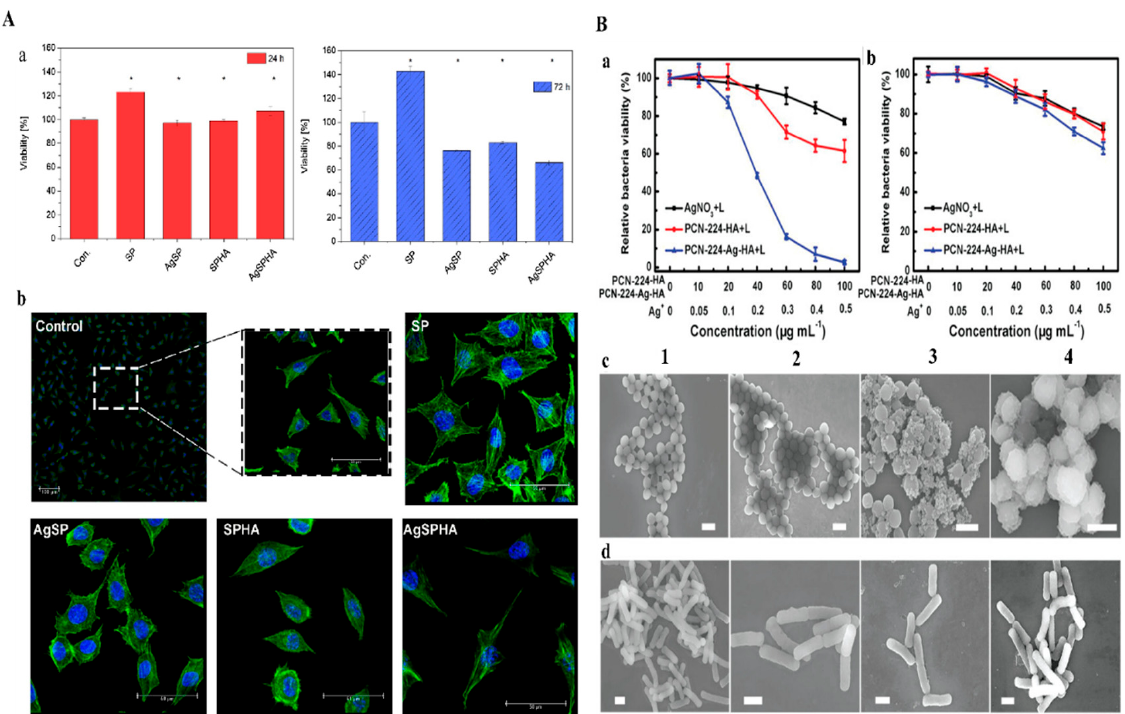
Figure 4. A ( a ) Cytotoxicity of at 24 and 72 h A ( b ) L929 Cell morphologies control and thermosensitive hydrogels for 1 day. DAPI stained nuclei (blue) and actin filaments stained with phalloidin − TRIC (green). Copyright 2019, Elsevier [71]. B ( a ) MRSA strain and B ( b ) drug resistance survival rates against E. coli under UV-light irradiation. SEM images for ( c ) MRSA and ( d ) drug resistance for E. coli after various treatments under UV-light irradiation (1) PBS (2) AgNO 3 (3) PCN − 224 − HA and (4) PCN-224 − Ag − HA. Copyright 2019, John Wiley and Sons [75].